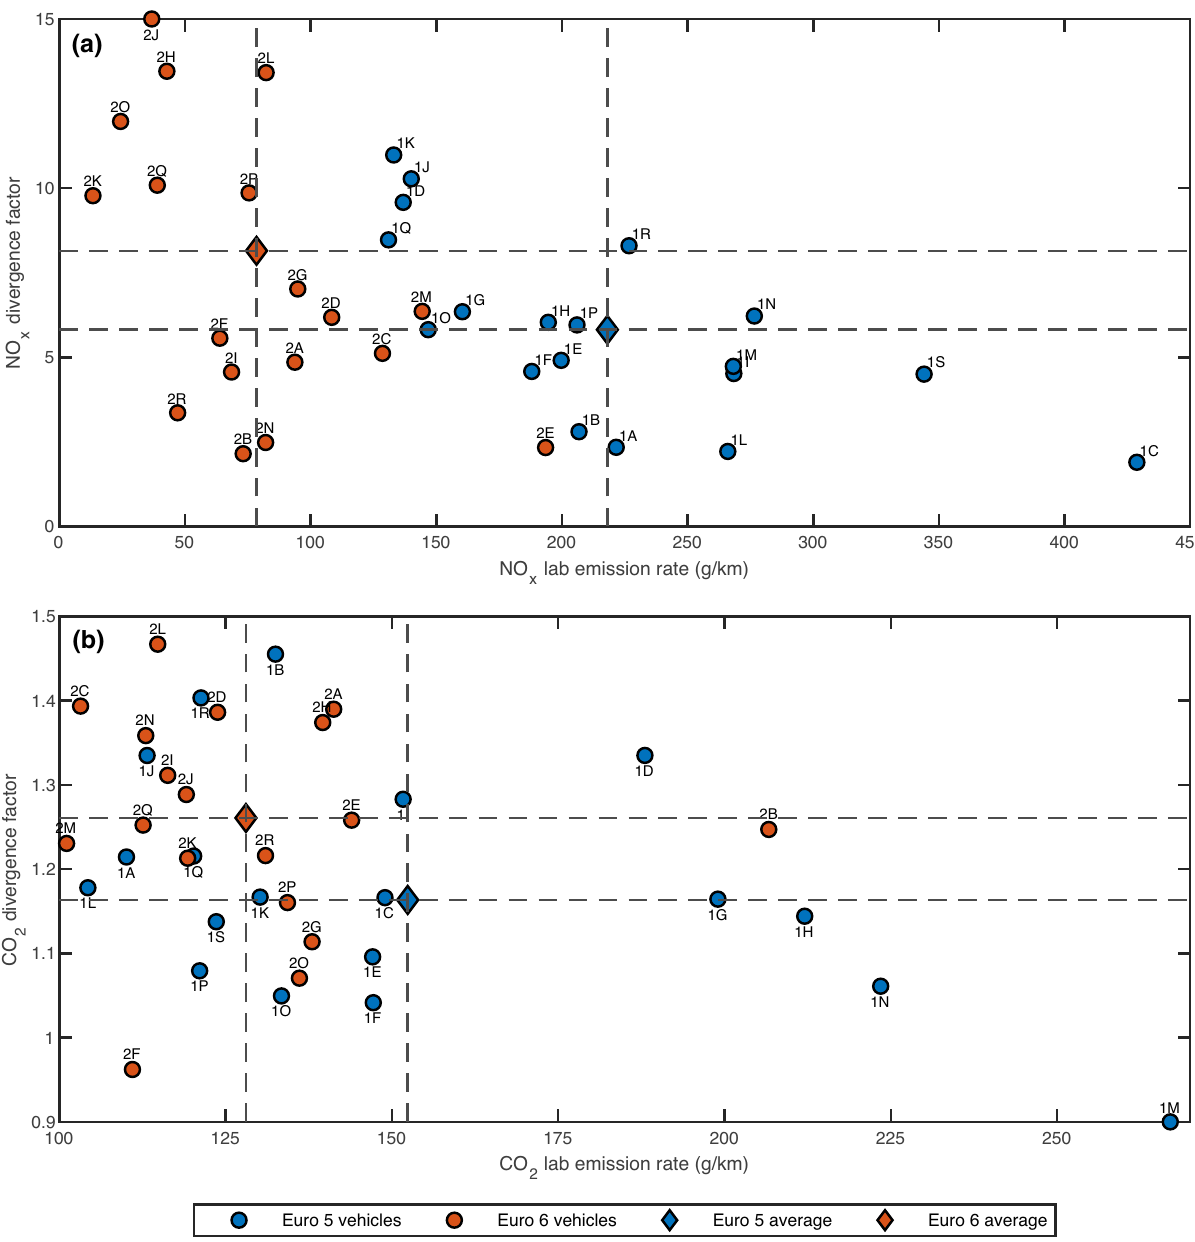
Figure 4. Development of NO x and CO 2 Lab-to-RDE divergence ratio from the Euro 5 to Euro 6 vehicle fleet. ( a , b ) NO x divergence factor ( a ), CO 2 divergence factor ( b ).The divergence factor is defined as the ratio of the RDE emission rate to the in-lab NEDC emission rate. Circular scatter points represent the divergence factor corresponding to the in-lab emission rate, and each point is denoted by the label of each tested vehicle as listed in Table 2. Advancing from the blue to orange diamond scatter point represents the development of the average divergence ratio moving from the Euro 5 to Euro 6 fleet. Note that the true points for 2 J in ( a ) and 1 M in ( b ) are located far outside of the axis limits. They are located at (36.8 mg/km, 28.1) and (267.7 g/km, 0.580)